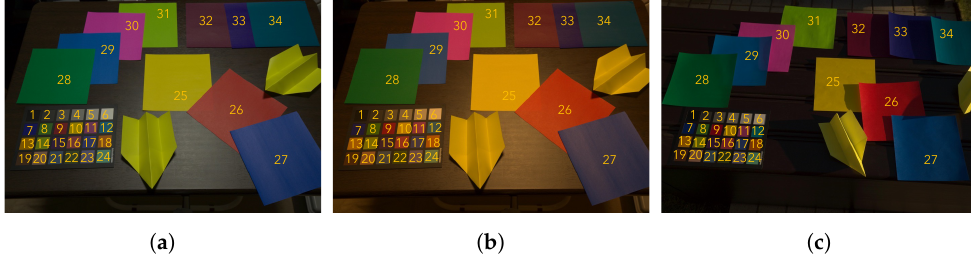
Figure 7. Images taken under three different light sources. ( a ) Ground truth image, ( b ) image taken under warm white light, and ( c ) image taken under daylight.